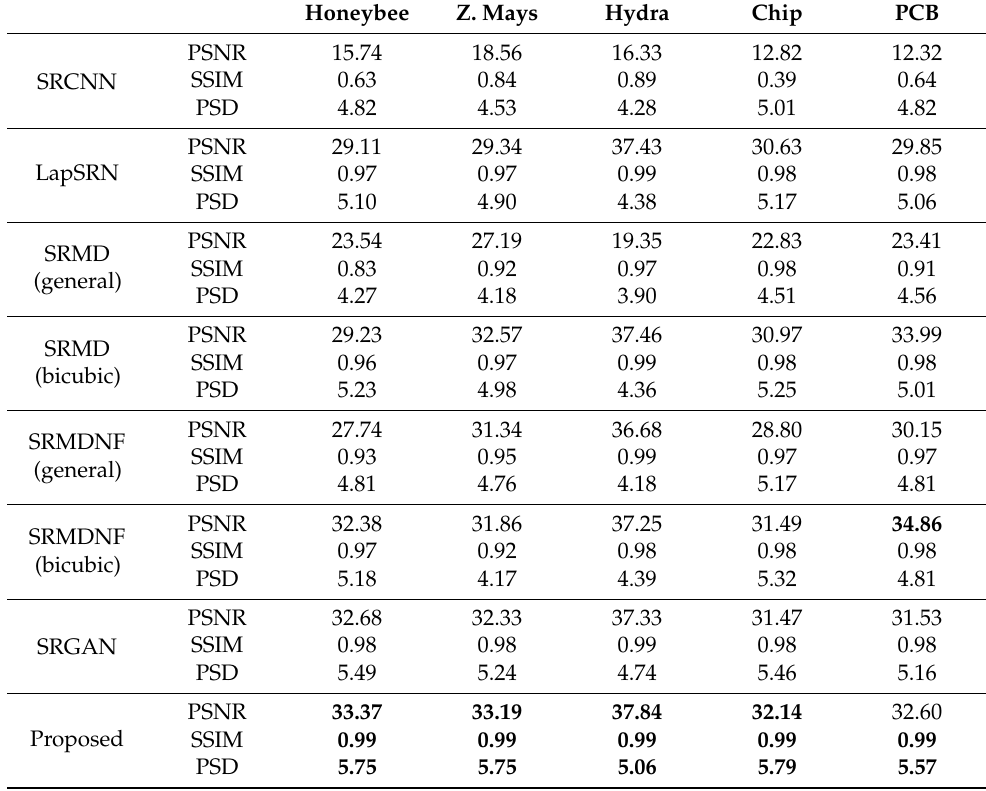
Figure 9. × 4 upscaling comparison. The SRCNN, LapSRN, SRMD, SRMDNF, and SRGAN algorithm are compared with the proposed method. In all cases, the proposed method performs better than others, and the super-resolved image is almost indistinguishable from the original. Table 1. PSNR, SSIM, and PSD comparison of the super resolved OVI ( × 2) using different algorithms. Most of the cases the proposed method performs better except the PSNR of the PCB specimen. However, the other parameters are still